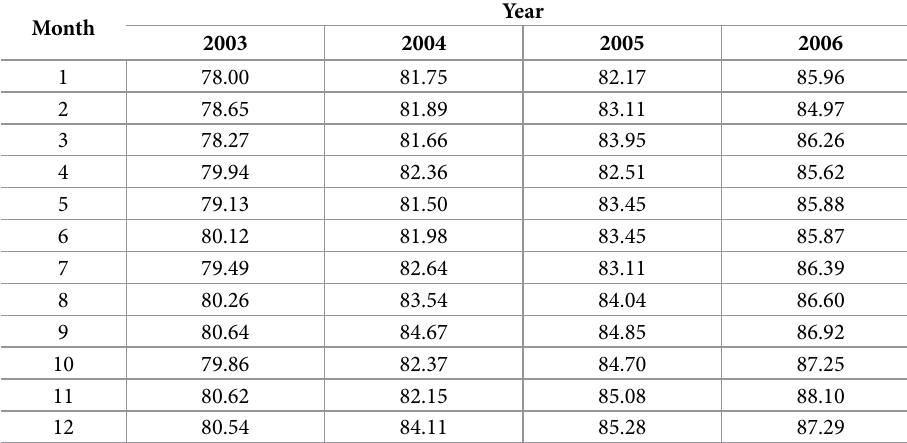
Table 3. Monthly profit of an organization, thous.